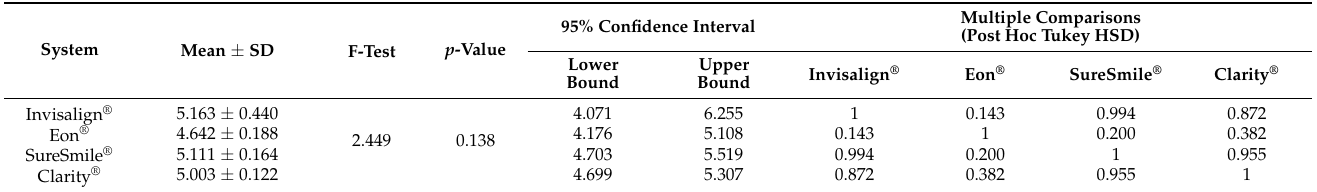
Table 1. Micro-hardness comparison of the different clear aligner systems via one-way ANOVA and Tukey post hoc tests.